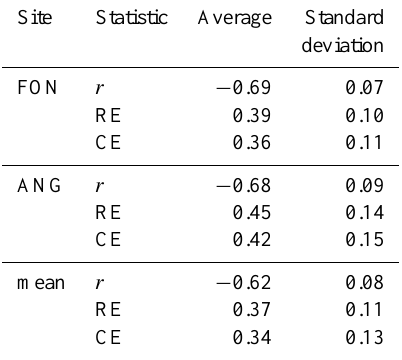
Figure 7. Comparison of cellulose δ 18 O chronologies from Fontainebleau (FON) and Angoulême (ANG). (a) 51-year running correlations between FON and ANG, the horizontal lines mark the 0.01 significance level for the high-pass (solid line) and low-pass (dashed line) filtered data; (b) low-pass filtered data; (c) high-pass filtered data; (d) standard deviation (SD) of the high-pass filtered data calculated for 51-year running windows; (e) number of trees. The blue and red shaded areas mark the parts of the FON and ANG chronologies respectively, where the number of trees is < 4.